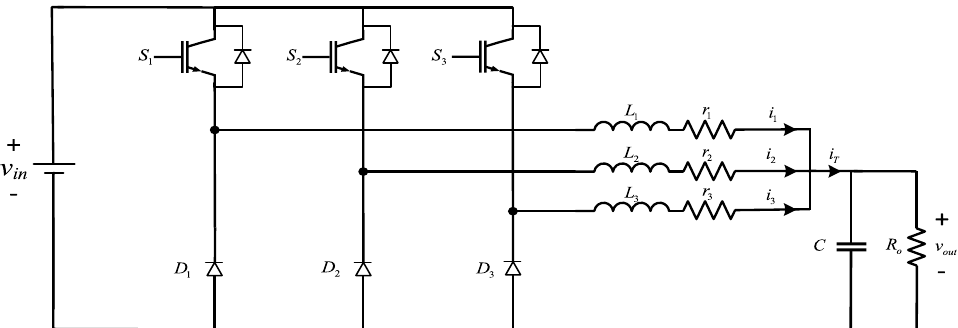
Figure 1. Three-phase interleaved buck converter